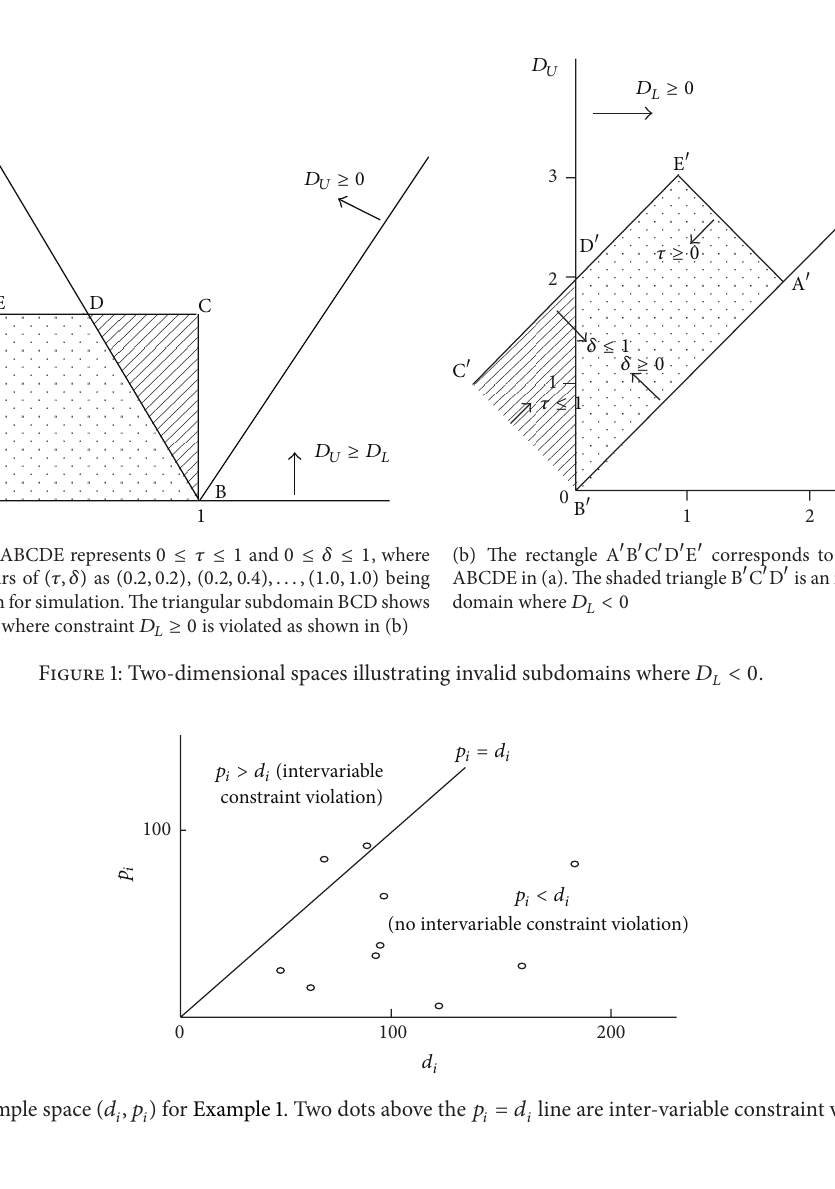
Figure 2: Sample space (𝑑 𝑖 ,𝑝 𝑖 ) for Example 1. Two dots above the 𝑝 𝑖 = 𝑑 𝑖 line are inter-variable constraint